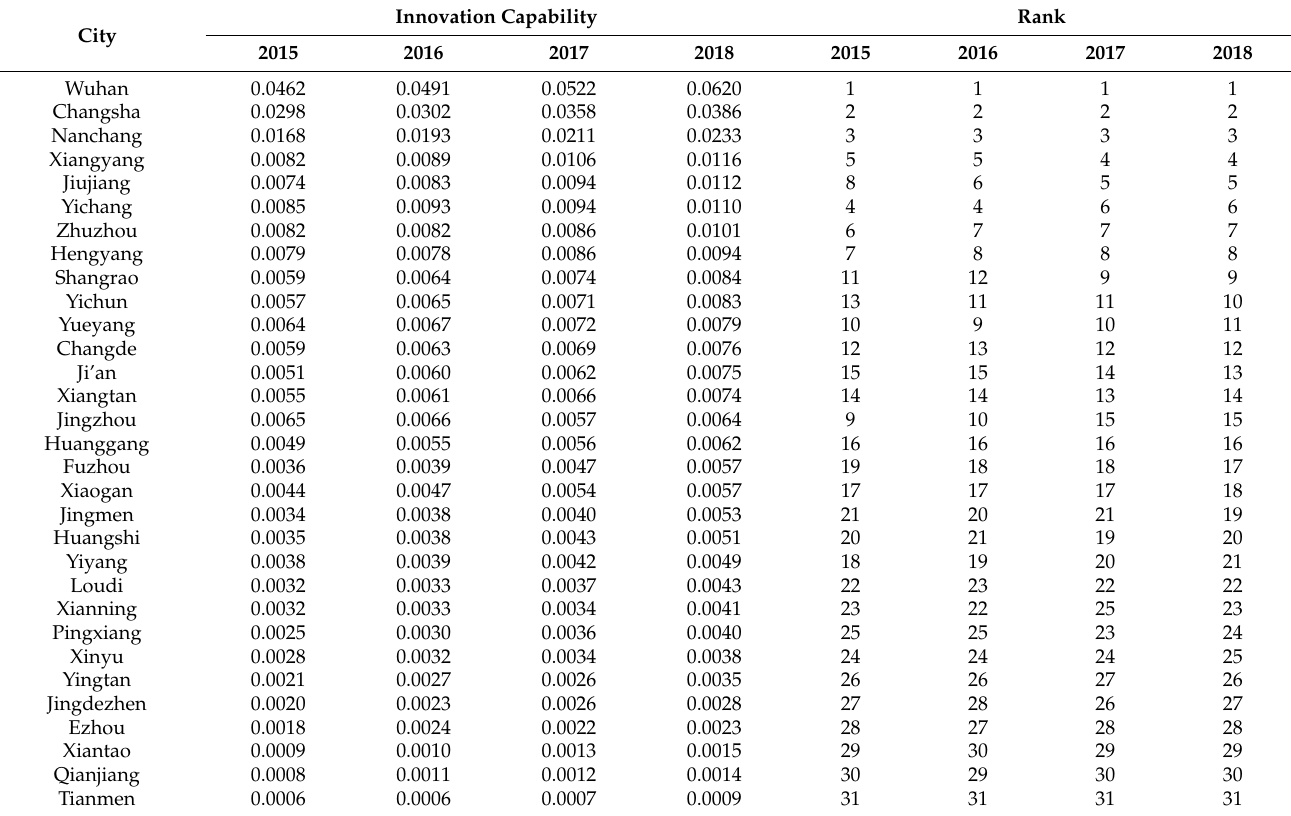
Table 3. Innovation capability and ranking of cities in the UAMRYR from 2015 to 2018. City